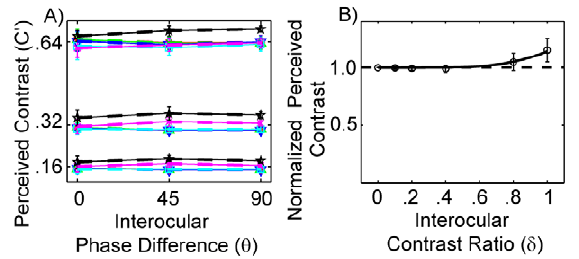
Figure 3. Phase-invariance and binocular advantage of con- trast combination. (A) Average perceived contrast ( C 0 ) of the cyclopean images versus interocular phase difference ( h ) in three different base contrast and six contrast ratio conditions. Red asterisk, green upward-pointing triangle, blue downward-pointing triangle, cyan square, magenta cross and black five-pointed star represent data from the six contrast ratio ( d =0, 0.1, 0.2, 0.4, 0.8 and 1.0) conditions. (B) Normalized perceived contrast as a function of interocular contrast ratio. The red curve represents the fit with the equation C 0 = C 0 ~ 1 z d u ð Þ 1 = u with u